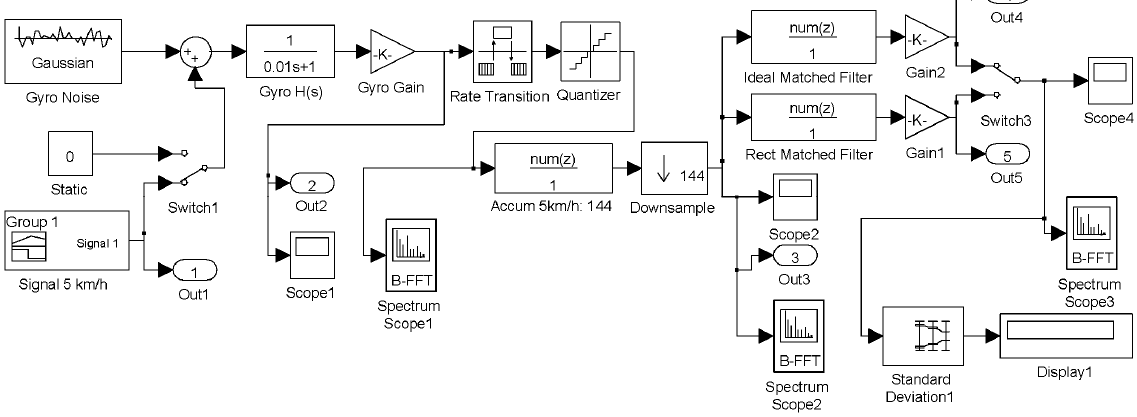
Figure 12. MATLAB ® -Simulink model of gyroscope and proposed 2-stage optimal processing. The simulation parameters shown in the figure correspond to a 5 km/h test.